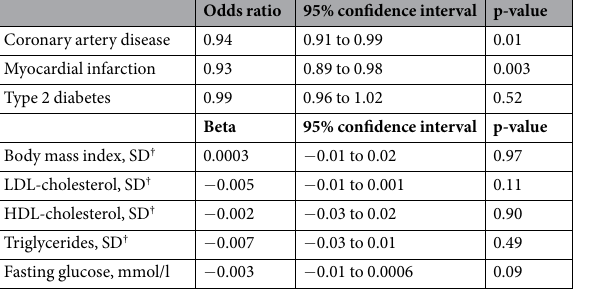
Table 3. Causal effect of handgrip strength (kg) on cardiovascular risk factors, diabetes and coronary artery disease. † 1-SD equals to 4.77 kg/m2 for BMI, 38.7 mg/dL for LDL-cholesterol, 15.5 mg/dL for HDL-cholesterol, and 90.7 mg/dL for